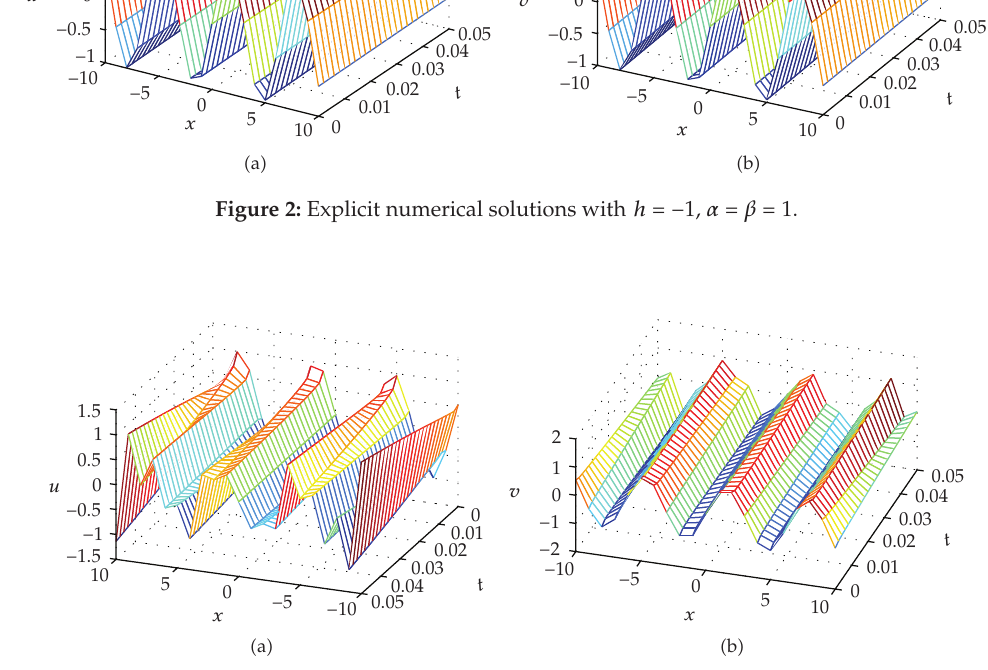
The absolute error of the 6th-order HAM and exact solution with h (cid:8) − 1 as shown in Figure 5. Also the absolute errors | u (cid:3) t (cid:4) − φ 6 (cid:3) t (cid:4) | have been calculated for in Table 2. Figure